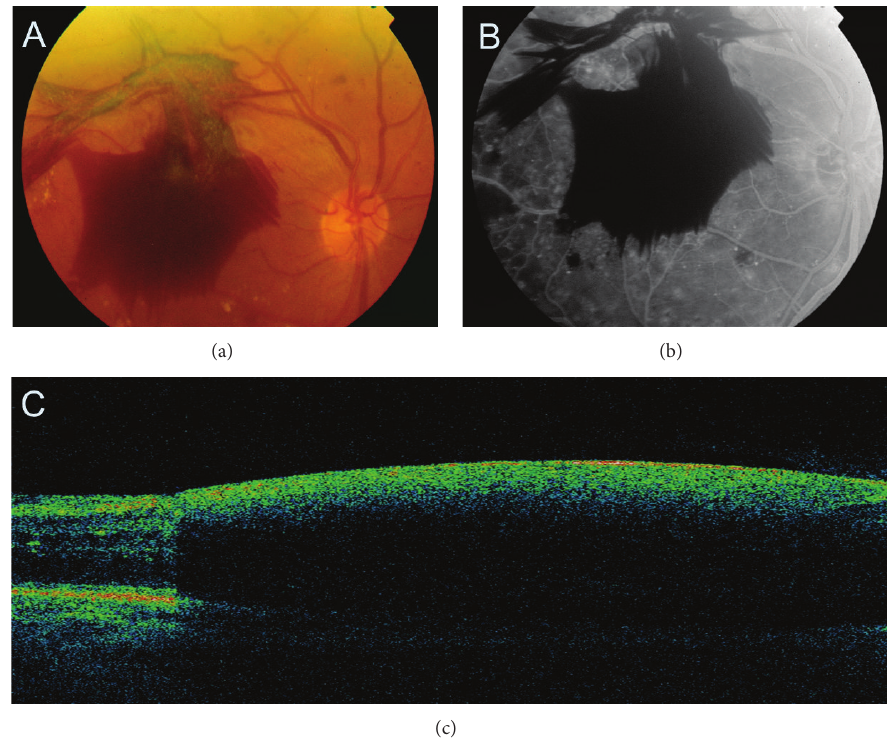
Figure 10: Proliferative diabetic retinopathy with dense preretinal haemorrhage. (a, b) Colour fundus photography and fluorescein angiogram. The view of the retina is obscured by the haemorrhage. (c) SDOCT cross-sectional image of the macula. The optical signal of the retina is shadowed by the